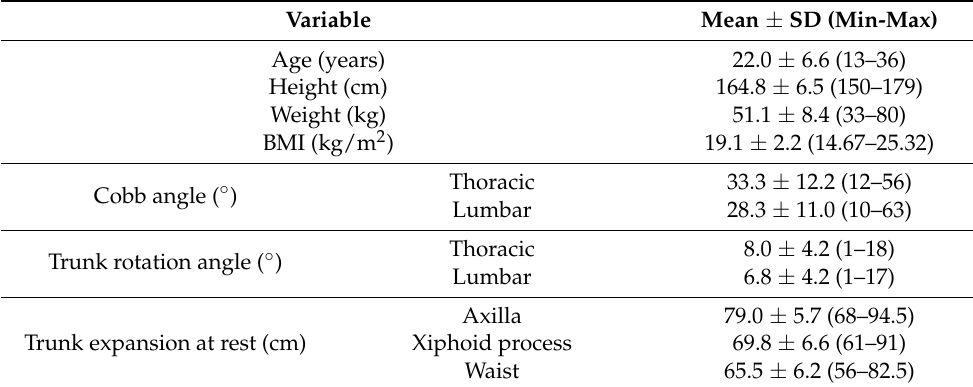
Table 3. General characteristics of the participants in the second experiment ( n =